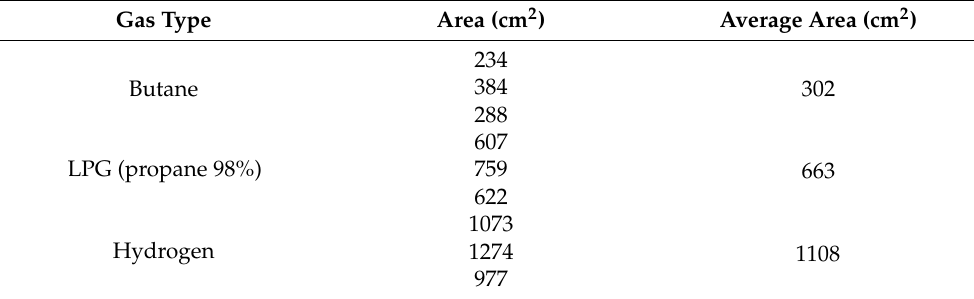
Table 3. Plastic sheet rupture shape areas for the cylinder-type chamber without tunnels.